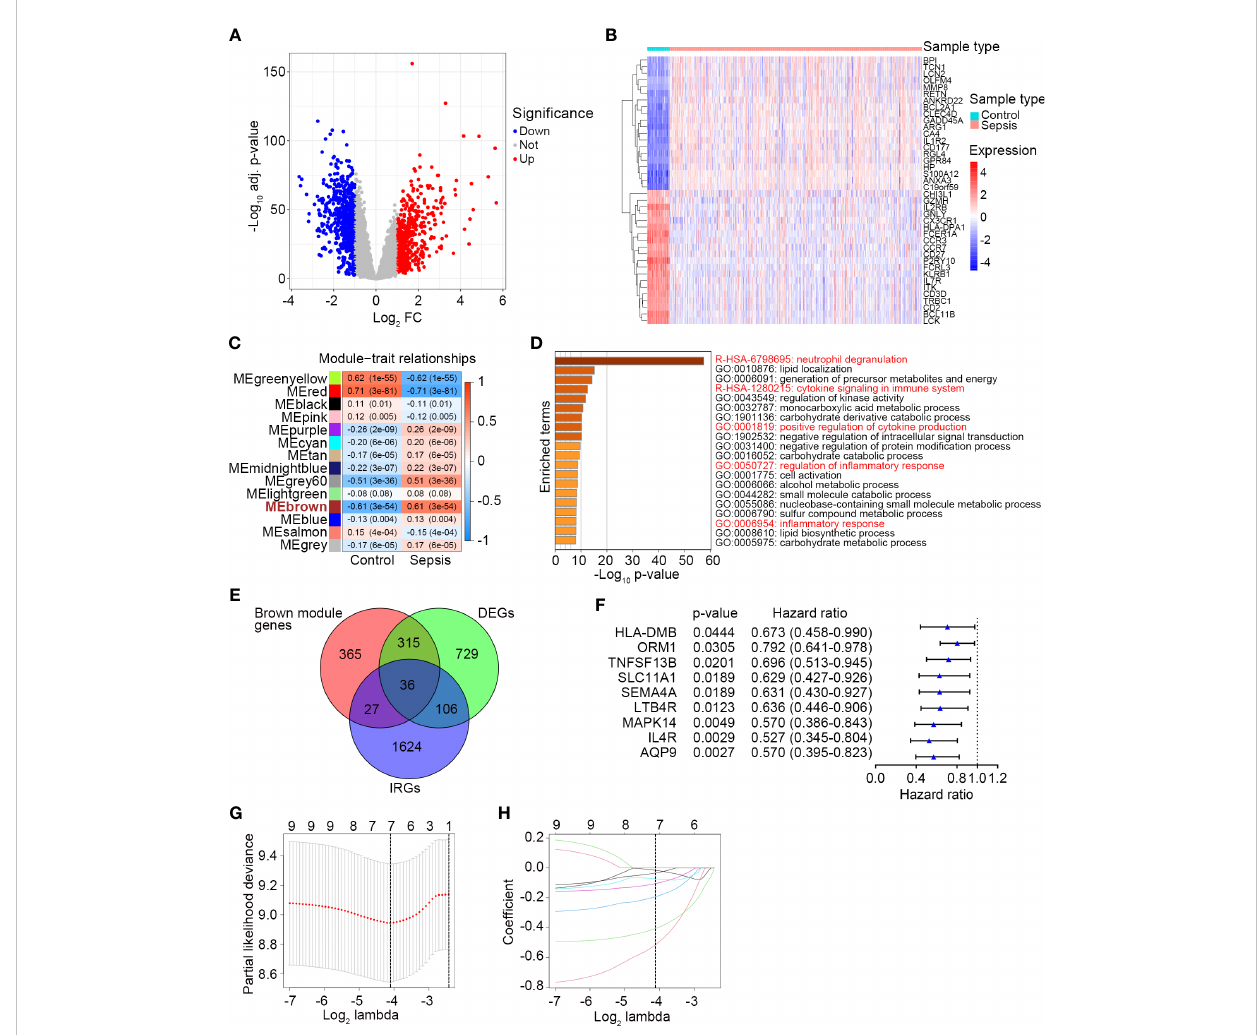
FIGURE 1 Identi fi cation of a prognostic IRG signature in sepsis. (A) The volcano plot showing DEGs between healthy controls (n = 42) and sepsis patients (n = 479) in GSE65682. The screening criteria were set as adjusted P-value < 0.05 and |Log 2 FC| ≥ 1. (B) The expression pro fi le of the most signi fi cant 20 upregulated and downregulated DEGs. (C) Plot of module – trait relationships by WGCNA analysis in the GSE65682 dataset. Each row represents a color module, and each column represents a clinical trait (healthy or sepsis). Each cell contains the corresponding correlation and P-value. ME, module eigengenes. (D) Top 20 enriched terms of the genes in the brown module analyzed by Metascape. (E) The Venn diagram of intersected genes of brown module genes, DEGs between healthy control and sepsis, and IRGs. (F) Univariate Cox regression analysis to screen IRGs related to 28-day survival of sepsis patients in the training set (n = 240) of GSE65682. Blue triangles represent the hazard ratio of death and open-ended horizontal lines represent the 95% con fi dence intervals. All P-values were calculated using Cox proportional hazards analysis. (G) Ten-fold cross- validation for tuning parameter selection in the LASSO estimation. The partial likelihood deviance corresponding to each lambda value is shown as mean ± SD. The dotted vertical line (left) indicates the optimal value by minimum criteria. (H) The LASSO coef fi cient pro fi le of individual genes included in the